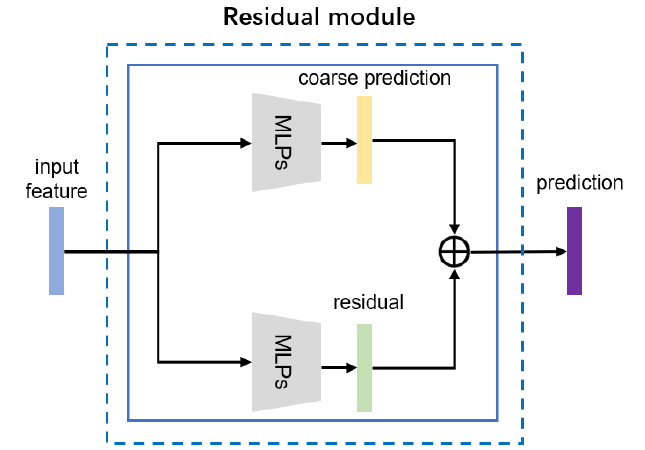
Figure 6. The architecture of the designed residual